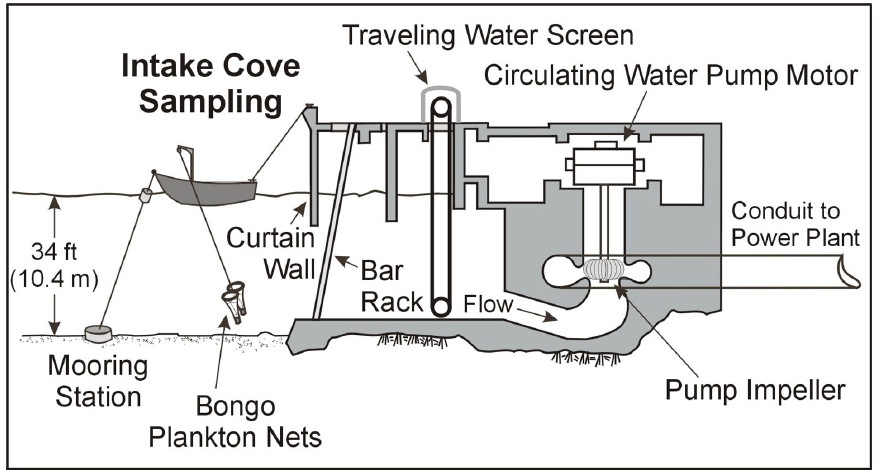
FIGURE 2. Cross-section view of the DCPP intake structure illustrating the location of the sampling boat and bongo